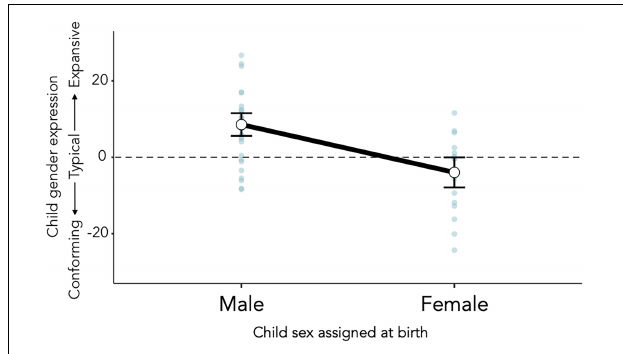
FIGURE 3 | Gender expansiveness scores were significantly higher among children assigned male at birth than among those assigned female.